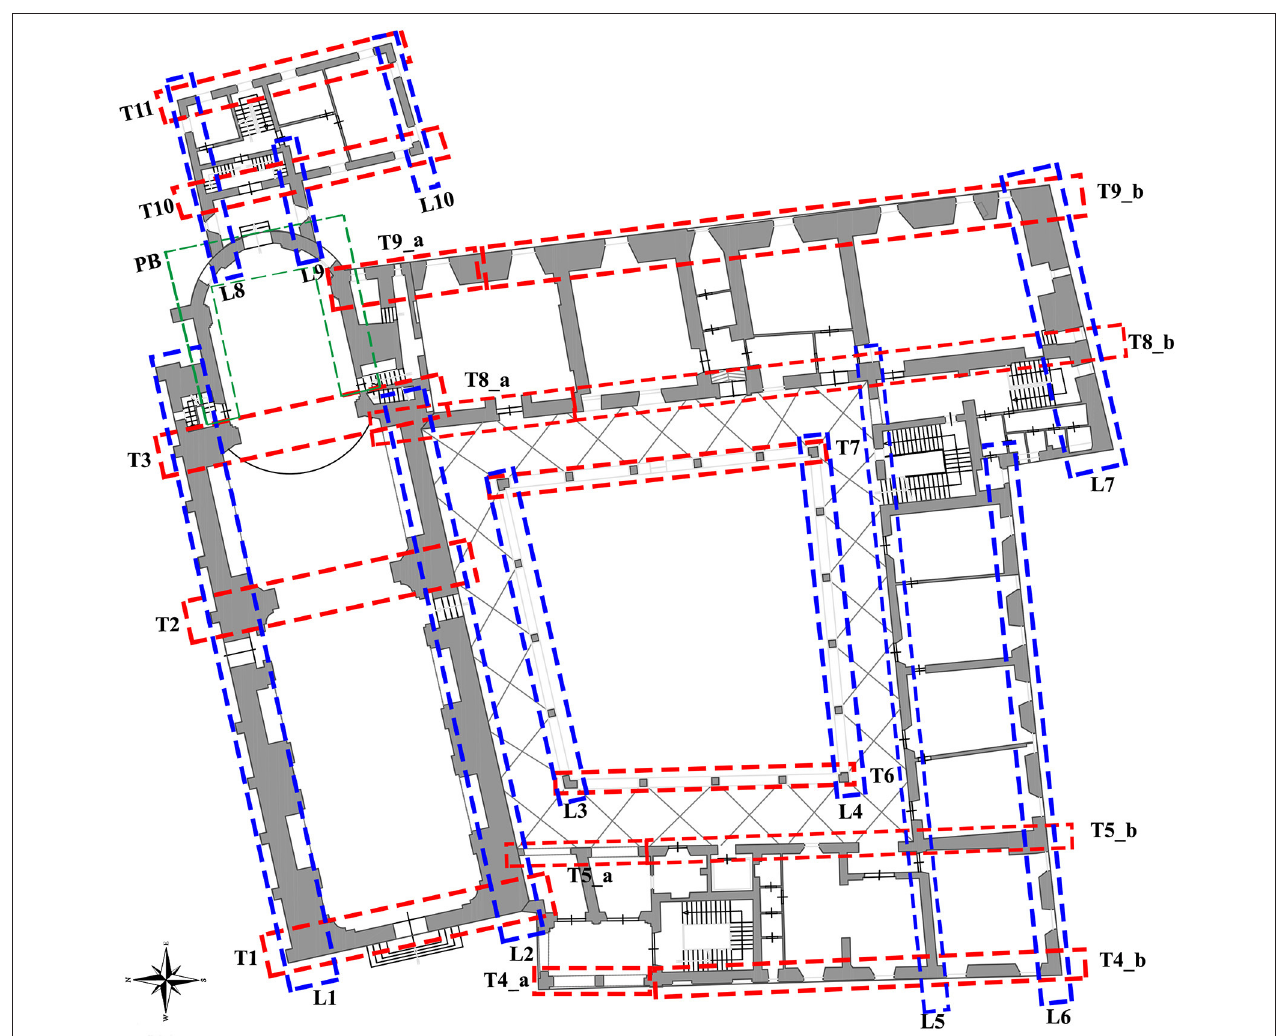
FIGURE 8 | Transversal (red) and longitudinal (blue)